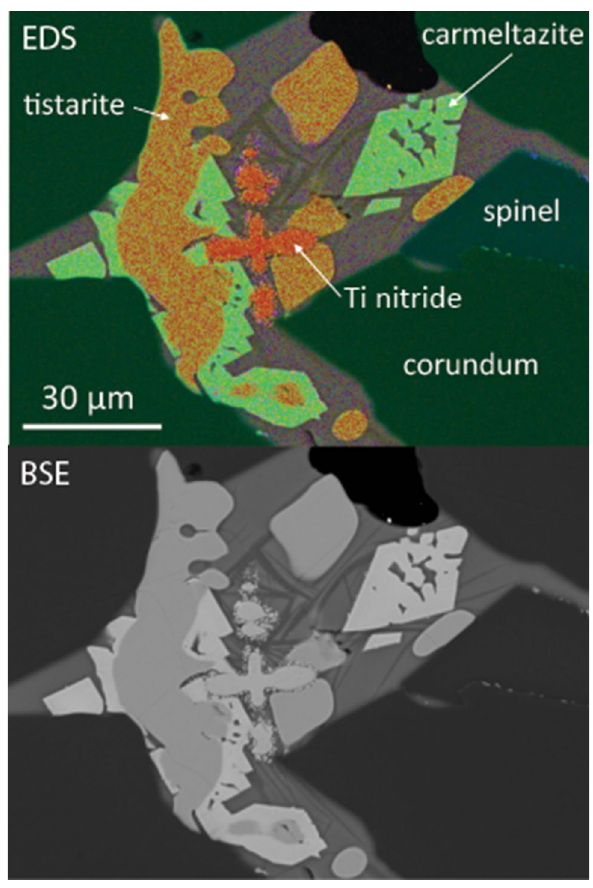
Figure 2. Melt pocket in corundum, showing the typical paragenesis of tistarite (Ti 2 O 3 ) and carmeltazite (ZrAl 2 Ti 4 O 11 ) in glass with quench crystals of dmisteinbergite (CaAl 2 Si 2 O 8